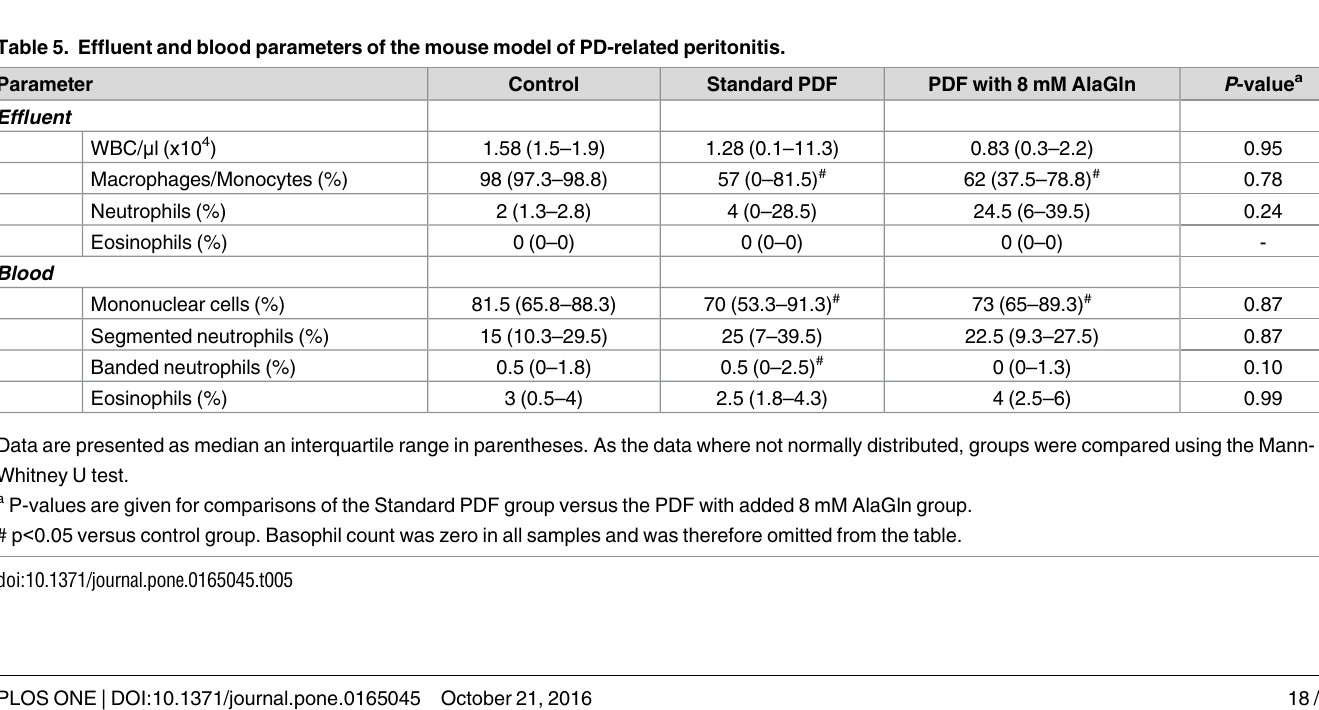
Fig 6. Levels of interleukin 8 (IL-8) and interleukin 6 (IL-6) in PET effluents from patients treated with PDF in the absence or presence of 8mM AlaGln. Each data point represents the IL-8 (A) or IL-6 (B) concentration in PD effluent of a single study patient treated with standard PDF lacking or containing added AlaGln. Among patients with history of peritonitis (Peritonitis Hx), IL-8 levels after exposure to PDF containingAlaGln were significantly lower than after exposure to standard PDF (p < 0.05). History of peritonitis was not associated with differences in IL-6 levels (p > 0.05). Statistical mixed model analysisfor IL- 6 was performed after excludingthe single extremely high value in the standard PDF group. Red bars indicate the medianin each group.